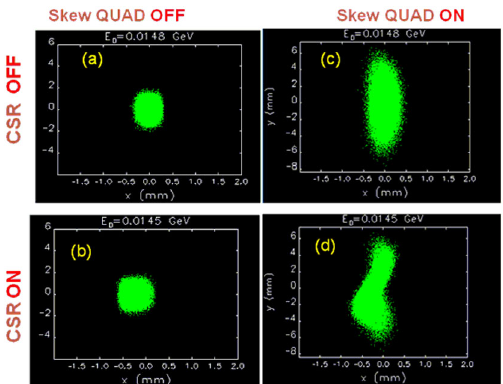
FIG. 10. ELEGANT simulation showing the effect of CSR and skew quadrupole at X24 with 5-cell off for 1 nC charge bunch. Part (a) shows both CSR and the skew quadrupole off. When there is no CSR, the skew quadrupole acts like a vertical deflector as shown in part (c). Because of CSR, the head particles gain energy leading to a transverse offset as shown in part (d). ¼ 80 (cid:5) m and (cid:2) ¼ 1 : 52 mm . Part (b) The rms size at X24 is (cid:2) x y shows the case with the skew quadrupole off and CSR